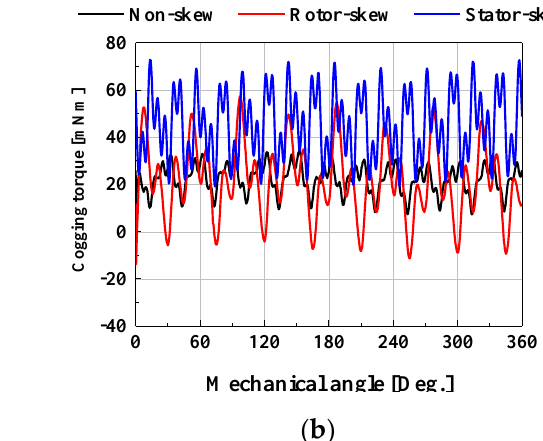
Table 4. Skew designs for the 3 prototypes. Model